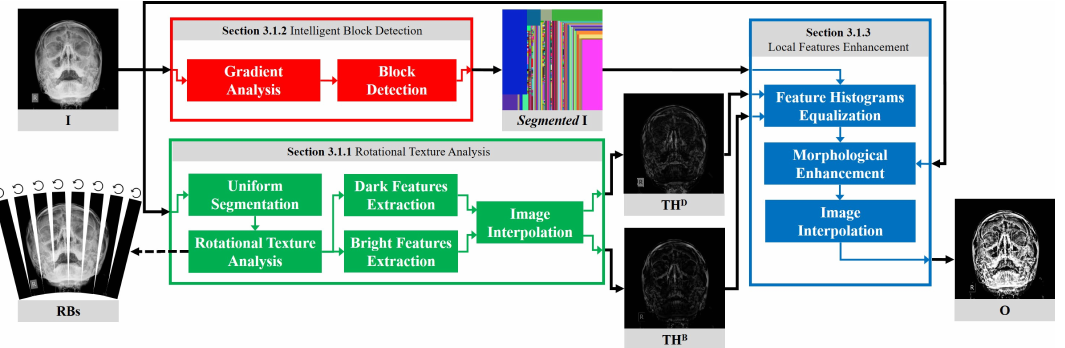
Figure 1. A step-by-step diagram of the image contrast enhancement for skull X-rays (SXRs) using proposed texture-oriented morphological